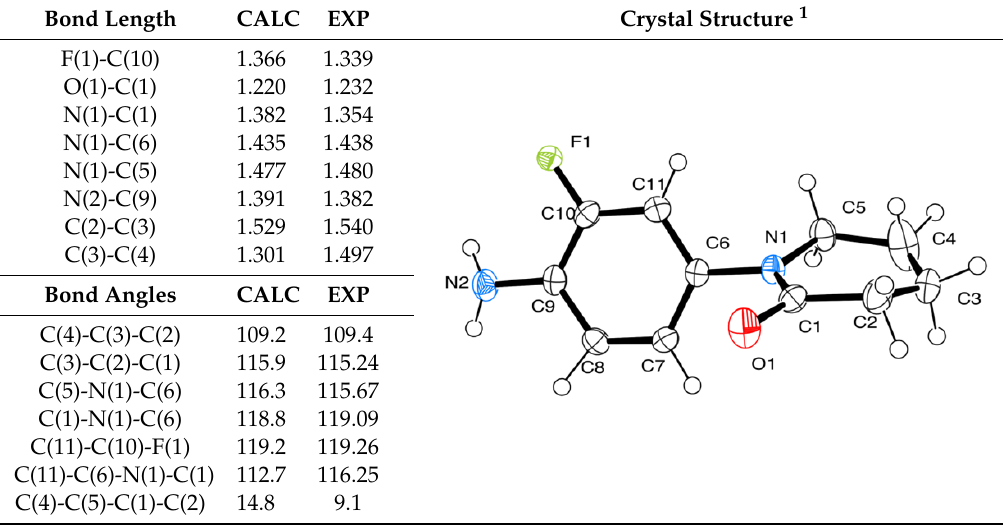
Table 6. Selected bond lengths and angles for molecule 9